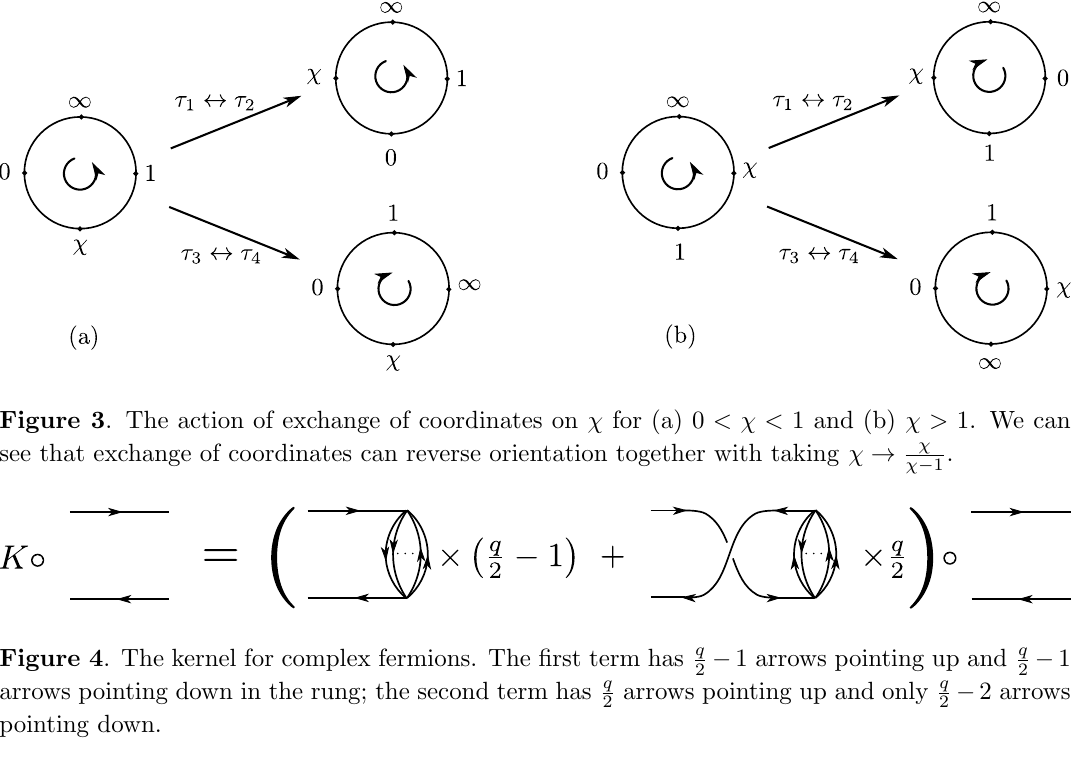
(cid:0) 1 2 (cid:0) 2 arrows 2